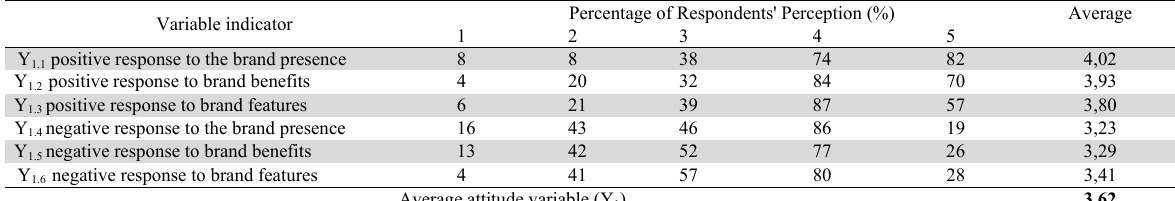
Description of Respondents' Perception of Attitude Indicators (Y 1 )